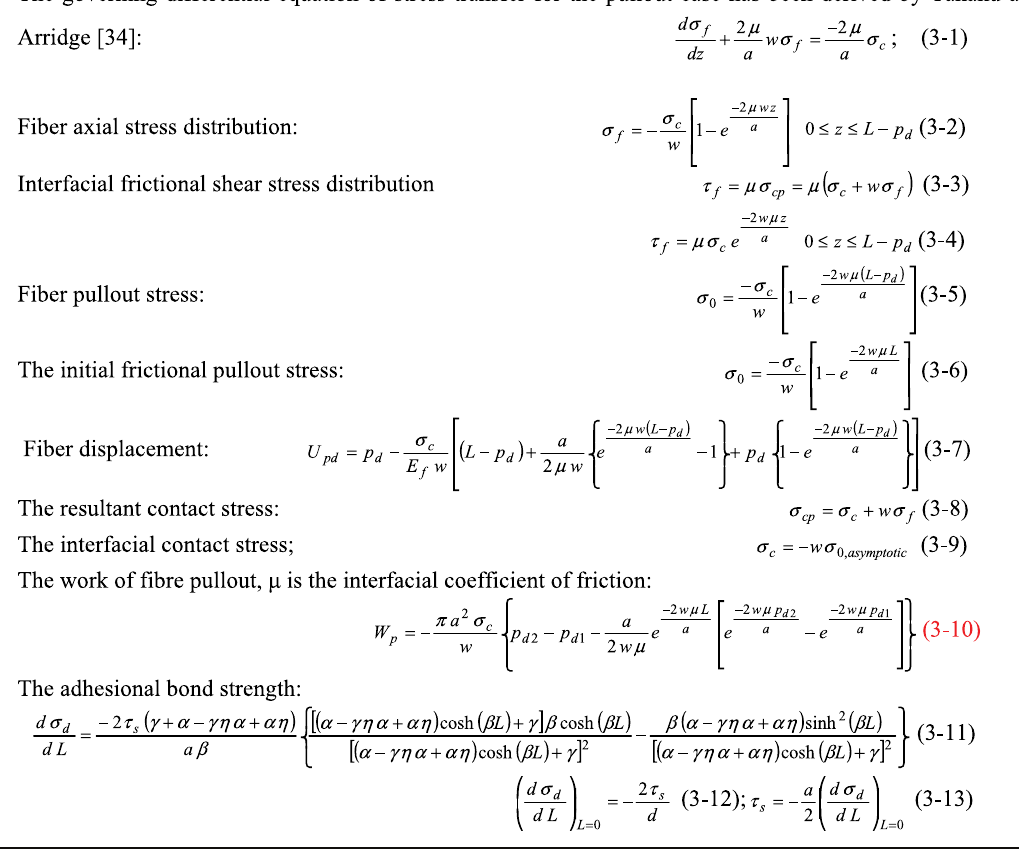
debonding). The closed-form solution for the initial debonding stress is derived based on a maximum shear stress criterion. This solution indicates that, among other factors, the initial debonding stress depends upon fiber length and fiber elastic proper- ties. At the end of stage 1, interracial debonding initiates at the location where the fiber enters the matrix